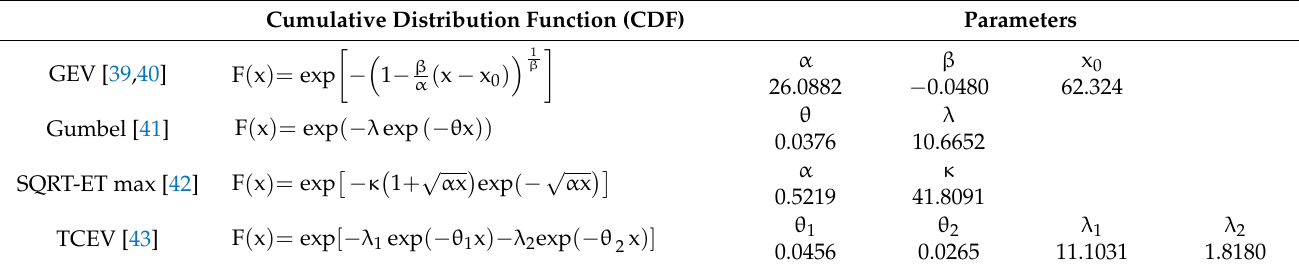
Table 3. Estimated parameters of the fitted distribution functions.